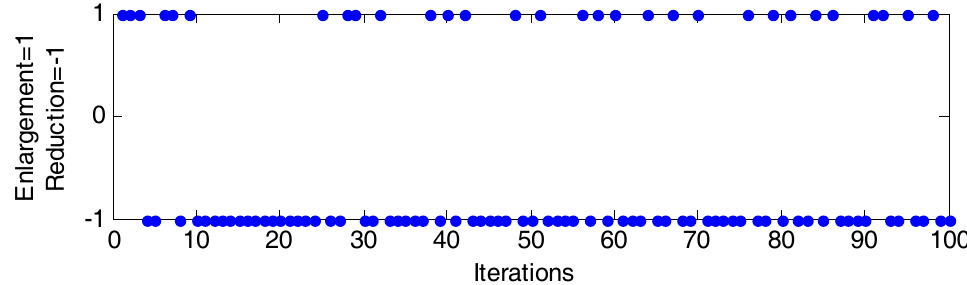
Figure 1. Enlargement and reduction of explosion amplitude (on the Sphere function).